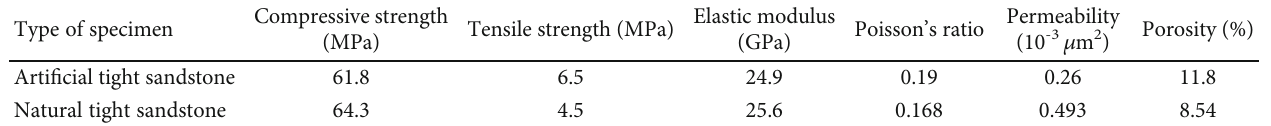
Table 1: The basic mechanical parameters of the arti fi cial experimental model and natural tight sandstone.